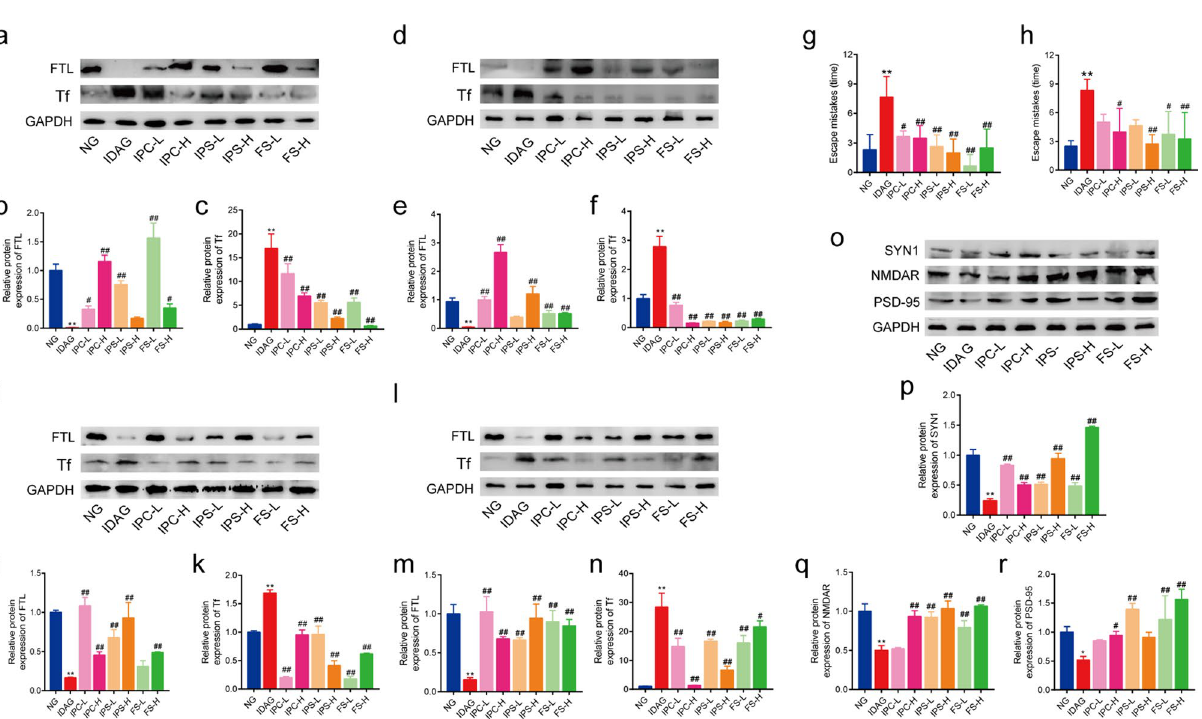
Figure 5. Iron related indexes and neural development of offspring rats after iron supplement treatment. Western blot analysis for FTL and Tf in liver ( a – c ) and spleen ( d – f ). Morris water maze test for day 1 escape latency ( g ) and day 2 escape latency ( h ). Western blot analysis for FTL and Tf in brain ( i – k ) and hippocampus ( l – n ), and for SYN1, NMDAR, PSD-95 in hippocampus ( o – r ). The quantification of western blotting was provided in supplementary material. FTL ferritin light chain, Tf transferrin, SYN1 synapsin 1, NMDAR N-methyl-D-aspartate receptor, PSD‑95 postsynaptic density protein 95. Data of Western blot analysis (mean ± SD) are expressed as the ratio of the relative contents between the value from IDA group and NG group and six iron treatment groups (n = 3). The relative contents of target proteins were quantified using the ratio between the optical density (OD) of target protein and the amount of the housekeeping protein GAPDH. ** p < 0.01, compared with NG, # p < 0.05, ## p < 0.01, compared with IDAG. One-way ANOVA followed by Tukey multiple comparison test was used for comparison among 8 different